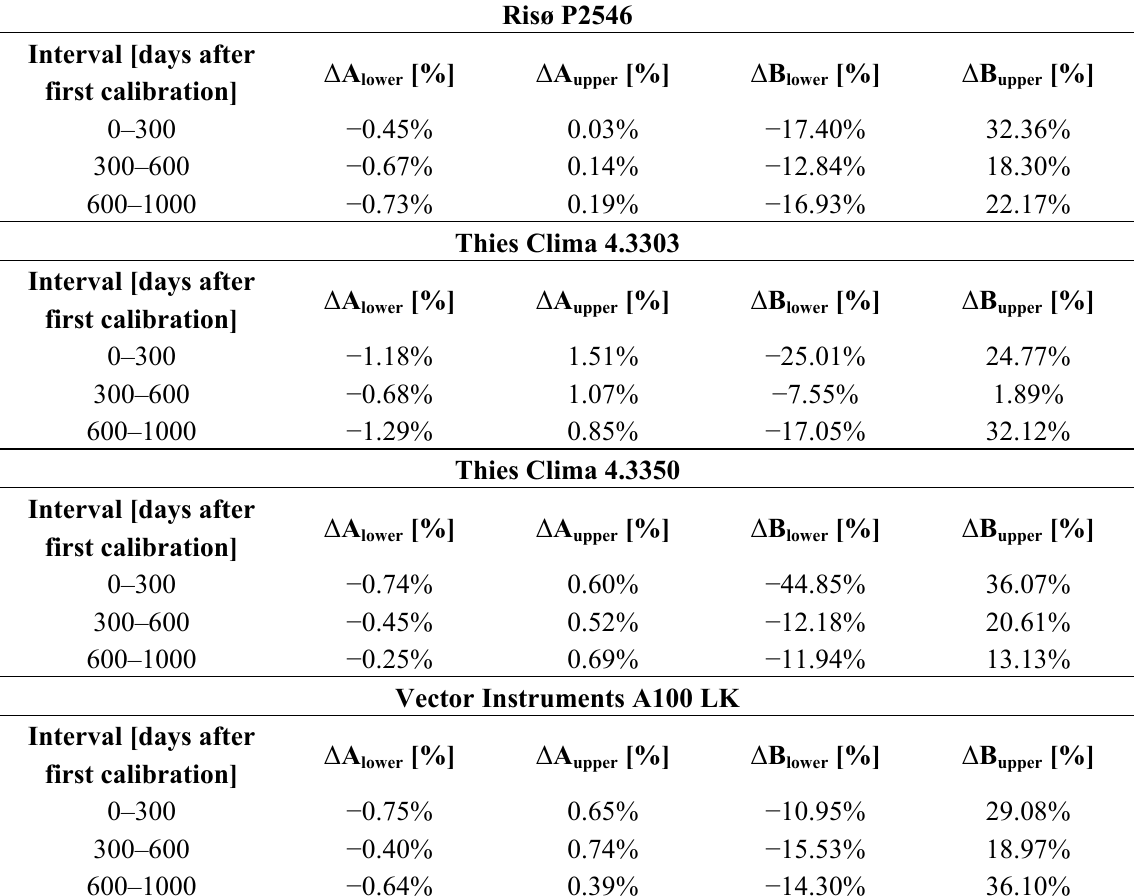
Table 7. 68.2% confidence limits ( Δ A of the constants A and B in the intervals 0–300, 300–600 and 600–1000 days from the initial calibration, with regard the anemometers studied (Risø P2546, Thies Clima 4.3303 and 4.3350, and Vector Instruments A100